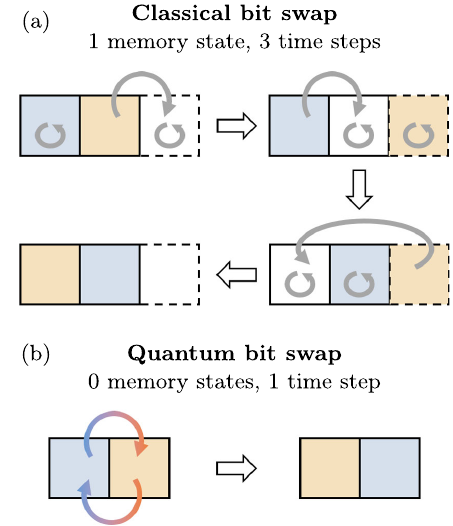
FIG. 1. Space-time cost for classical and quantum bit swap. (a) Space-time optimal realization of a bit swap, i.e., a trans- position between two states (solid-line boxes), using one memory state (dashed-line boxes) and three time steps. Each time step is composed of a continuous memoryless dynamics that does not affect one of the states and maps the remaining two to one of them. (b) In the quantum regime, a bit swap can be performed without any memory, simply by a time-continuous unitary t Þ that continuously connects the identity oper- process exp ð i σ x ation at time t ¼ 0 with the bit swap, represented by Pauli x operator σ , at time t ¼ π = 2 . During the process, the information x about the initial state of the system is preserved in quantum